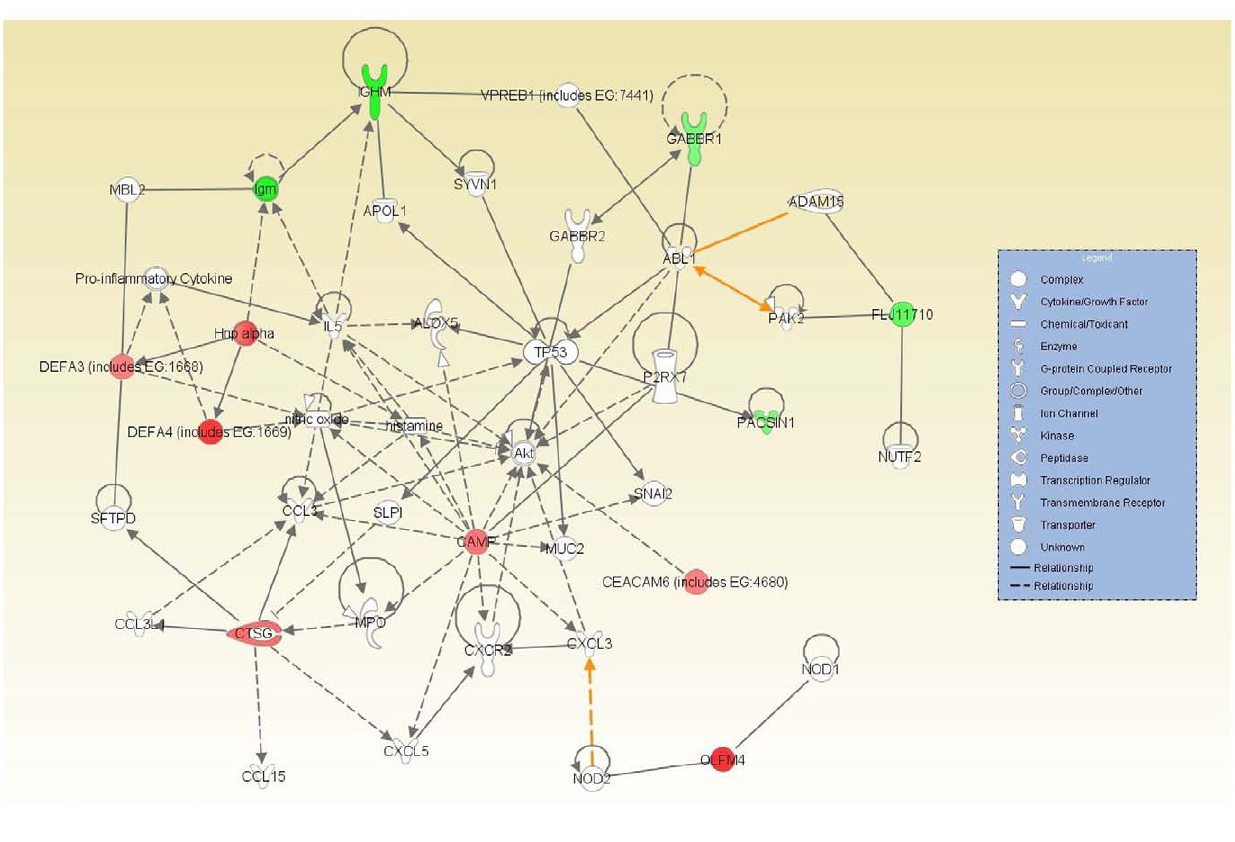
Figure 4. Overlaid networks and associated pathway analysis . Solid lines (direct relationship); Dashed lines (indirect relationship); Red filled (up-regulation); and Green filled